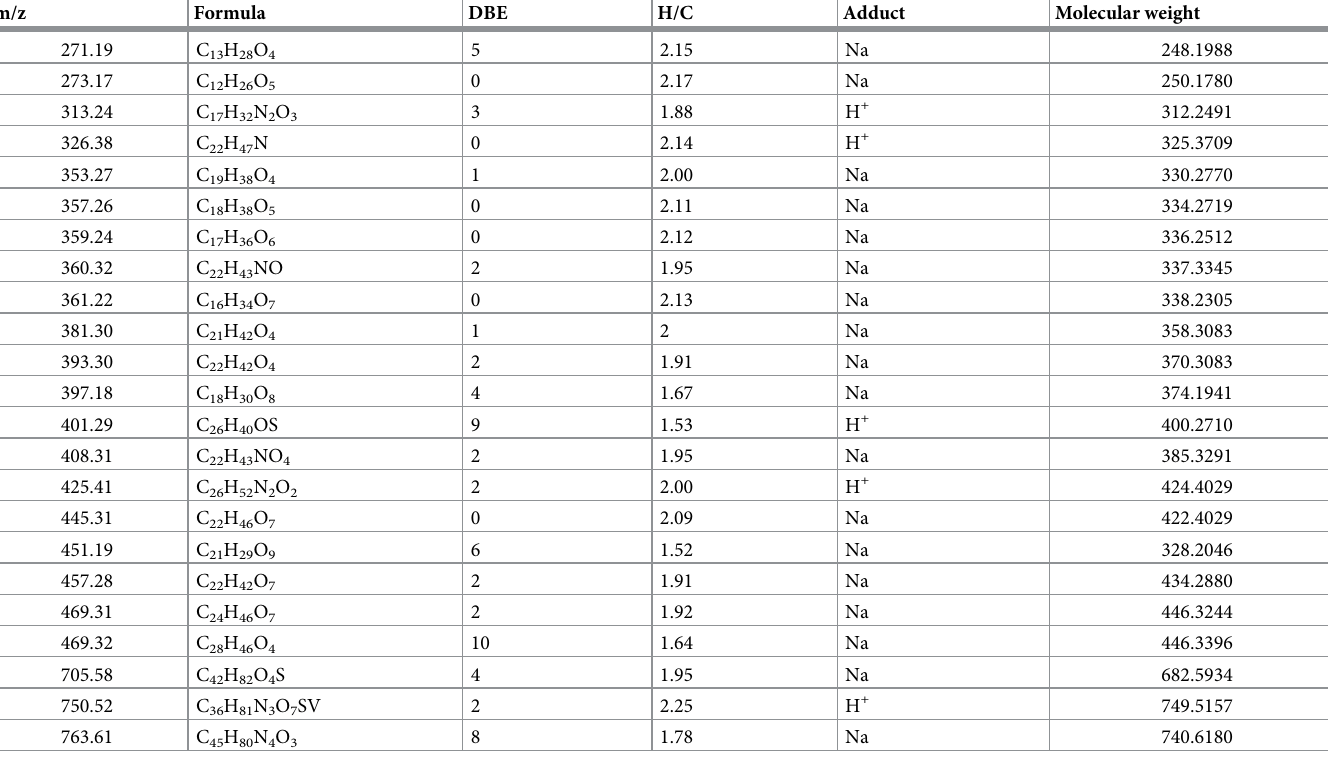
Table 4. The variables selected by PLS-DA through VIP.